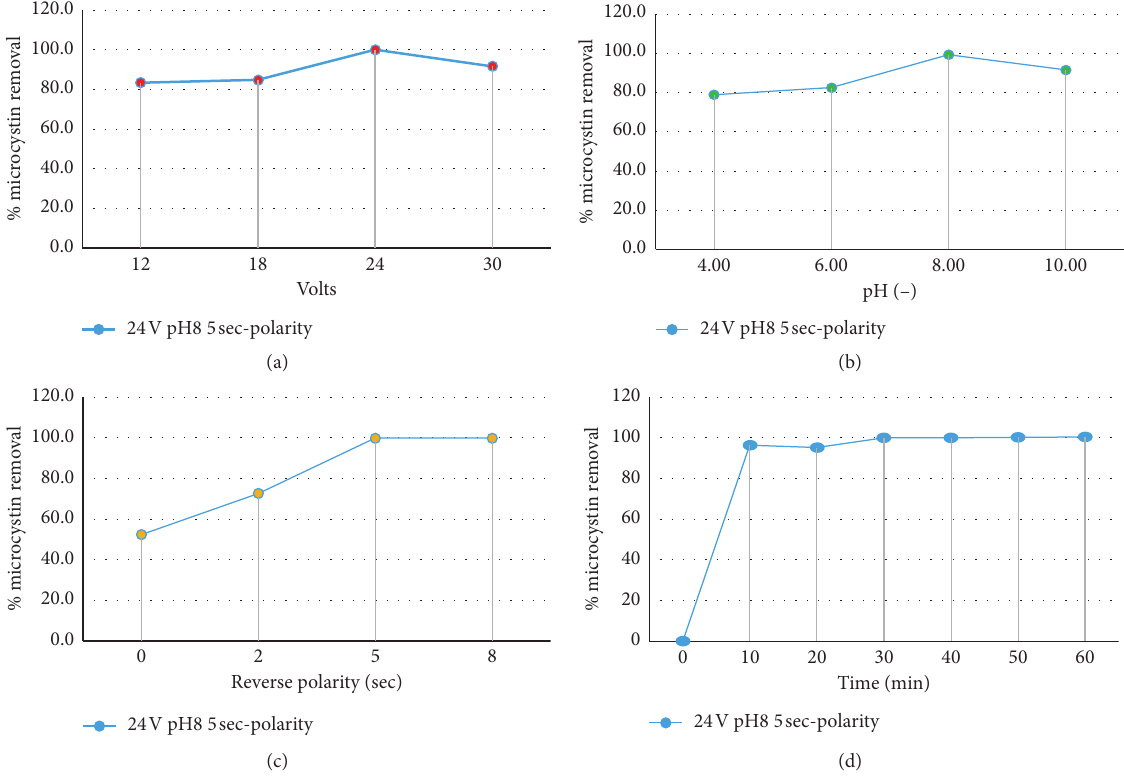
Figure 6: Microcystins removal efficiency based on (a) voltage discharge, (b) pH, (c) polarity, and (d) combined